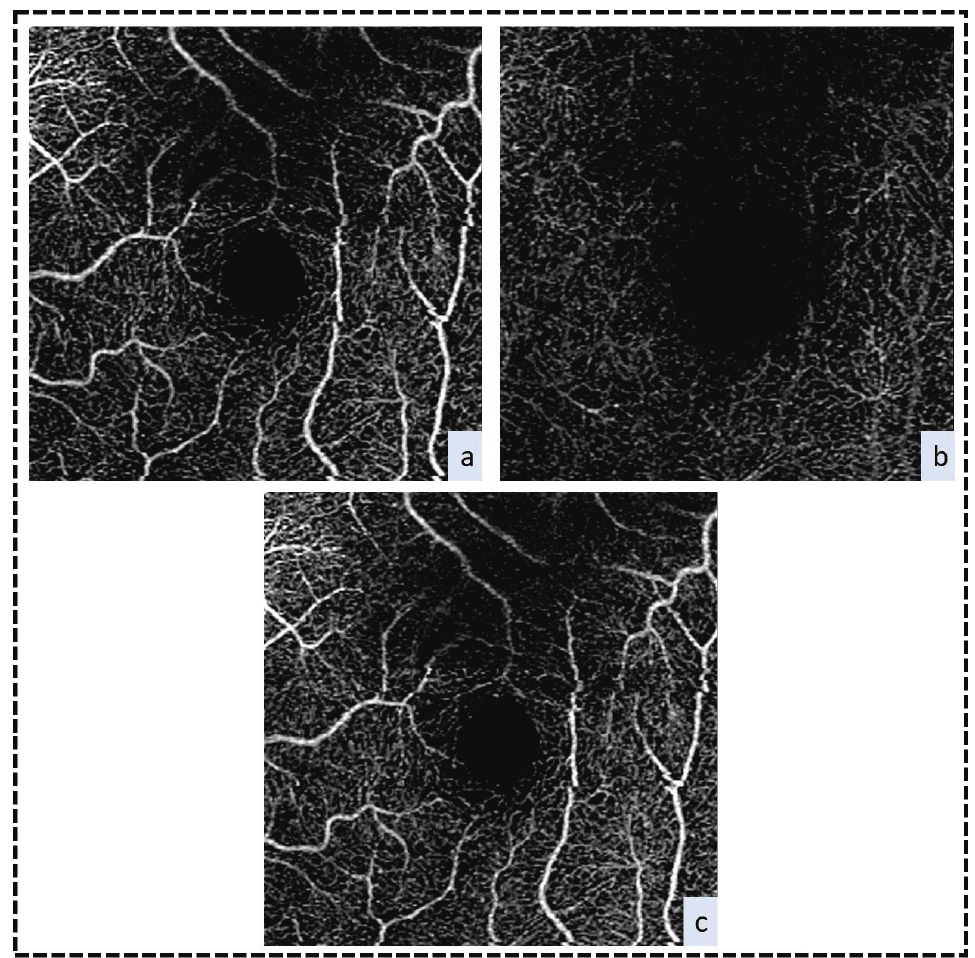
Figure 5. RVO. OCTA scan showing various plexuses for RVO subject: ( a ) superficial plexus, ( b ) deep plexus, ( c ) whole